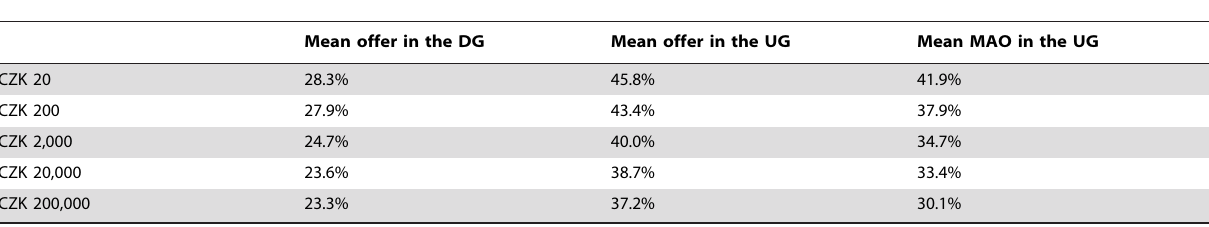
Table 1. Mean offers in the DG and the UG.